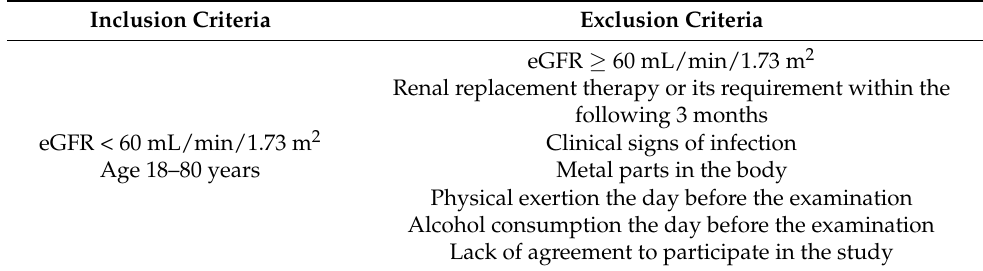
Table 1. The inclusion and exclusion criteria for the studied